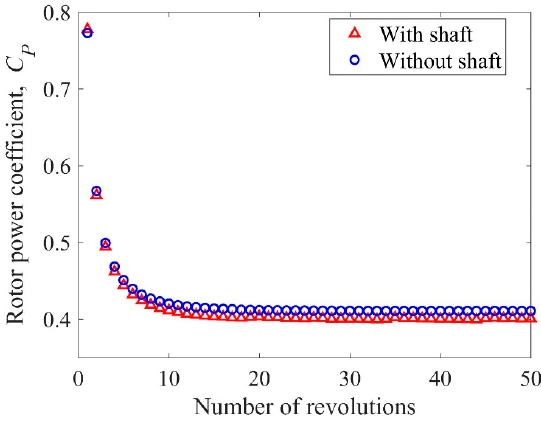
Figure 13. History of the rotor power coefficient for the shafted rotor and the clean one.